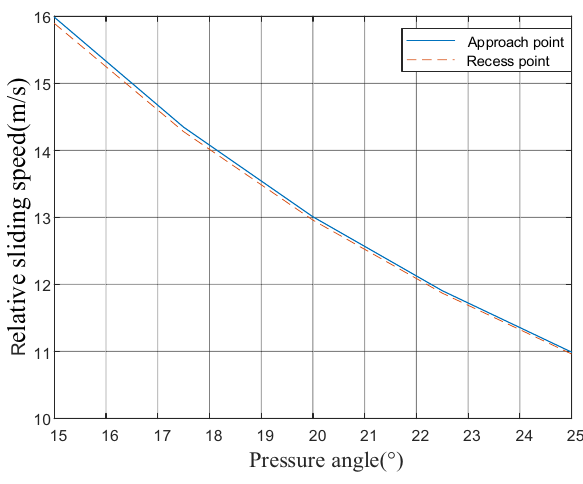
Fig. 14 Influence of modification coefficient on transmission effi-